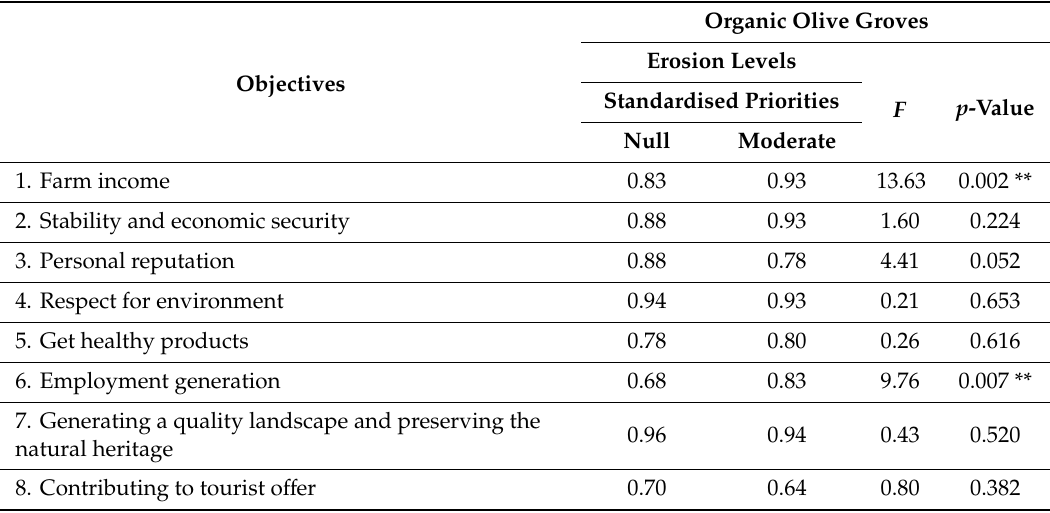
Table 6. Standardised priorities for the evaluated objectives of organic olive groves in the Estepa region within their erosive levels. Statistical values of F (Kruskal–Wallis test) and p -values; significant ( < 0.05 *), very significant ( < 0.01 **), and highly significant ( < 0.001 ***) are